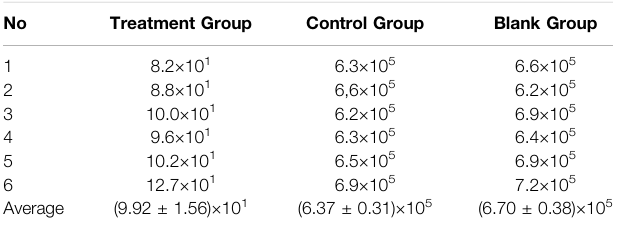
TABLE 2 | Counts of bacterial content in each group of bone tissue after 28 days of